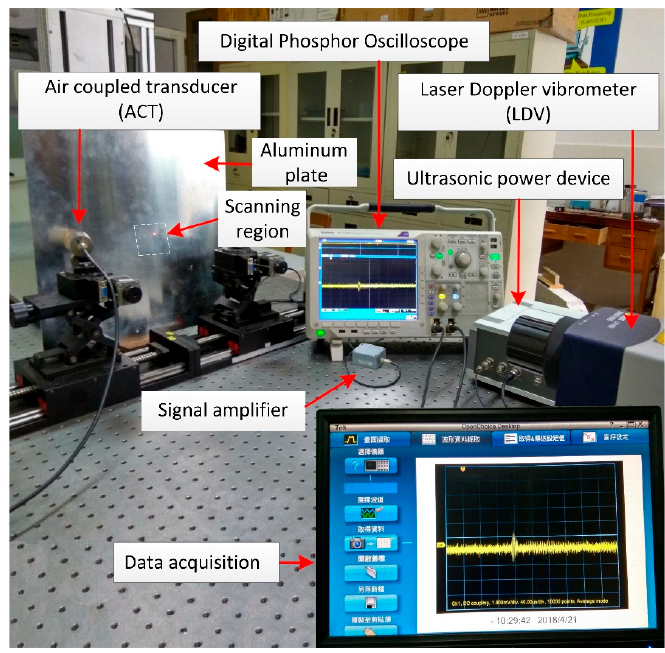
Figure 16. Schematic of the experimental setup.